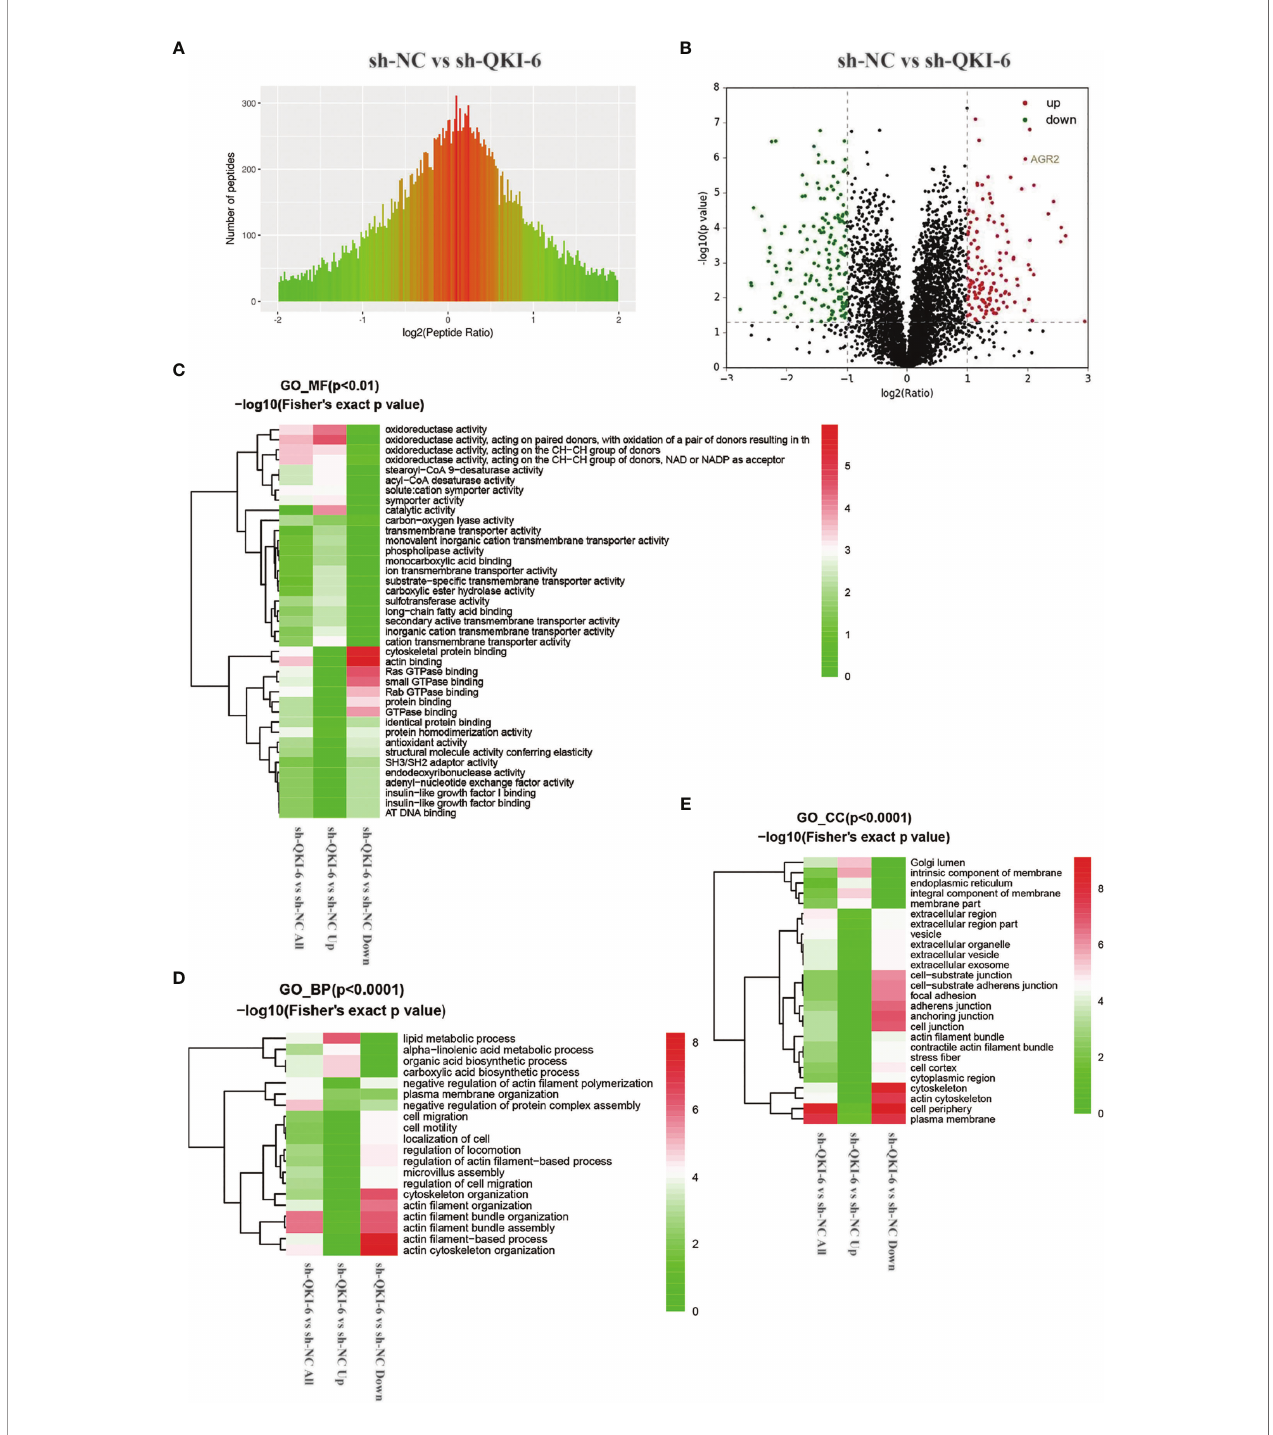
FIGURE 4 | Different proteins and ontologies were identi fi ed by label-free quantitative proteomics technology. Functional annotation of dysregulated proteins analyzed by Protein Analysis Through Evolutionary Relationships (PANTHER) by using the Gene Ontology (GO) categories molecular function (MF), biological process (BP), and cellular component (CC). (A) Differences in peptide quantitative ratio distributions between knockdown QKI-6 A549 cells and control groups. (B) Volcano plot showing differential expression of proteins between knockdown QKI-6 A549 cells and control groups. (C – E) Heat map showing functional enrichment-based clustering for protein groups: GO molecular function cluster (C) , GO biological process function cluster (D) , and GO cellular component function cluster (E)